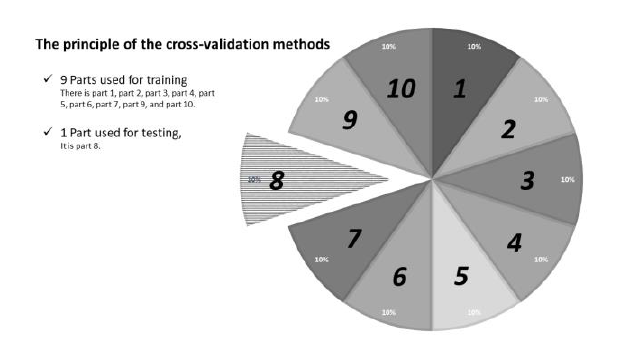
Fig. 4. The principle of the cross-validation